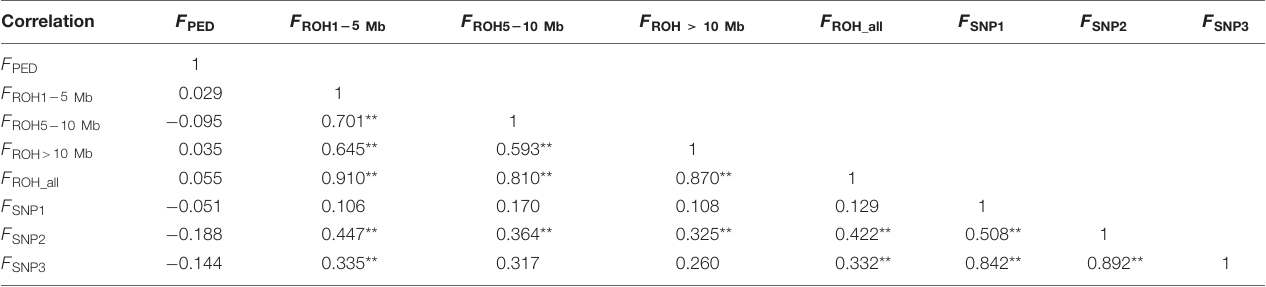
TABLE 2 | Correlation coefficients (lower panel) among eight types of inbreeding coefficient estimates ( F PED , F ROH1 − 5 Mb , F ROH5 − 10 Mb , F ROH > 10 Mb , F ROH_all , F SNP1 , F SNP2 , and F SNP3